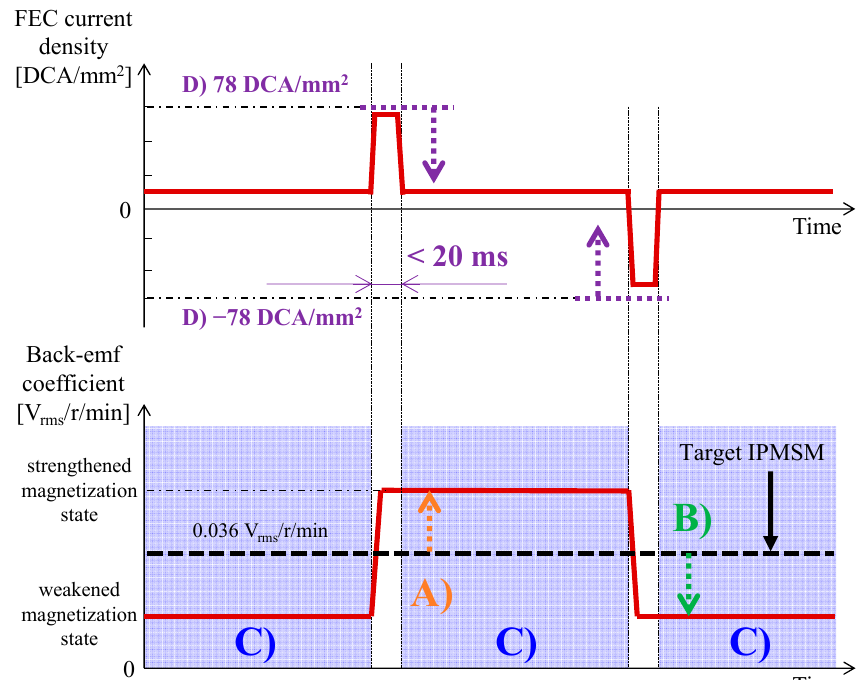
Figure 5. Detailed specifications of design criteria.